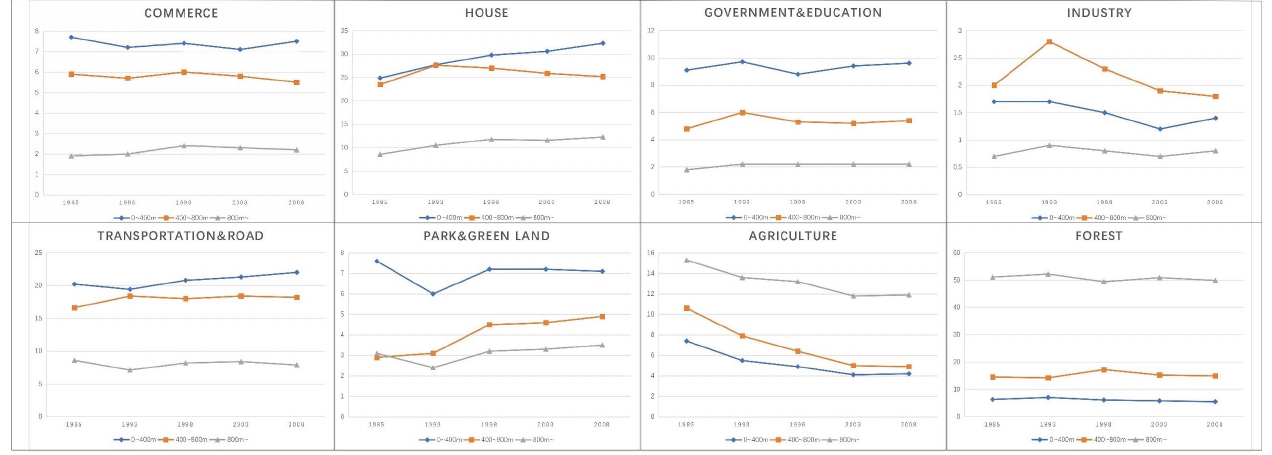
Figure 5. Changes in land use around station zones